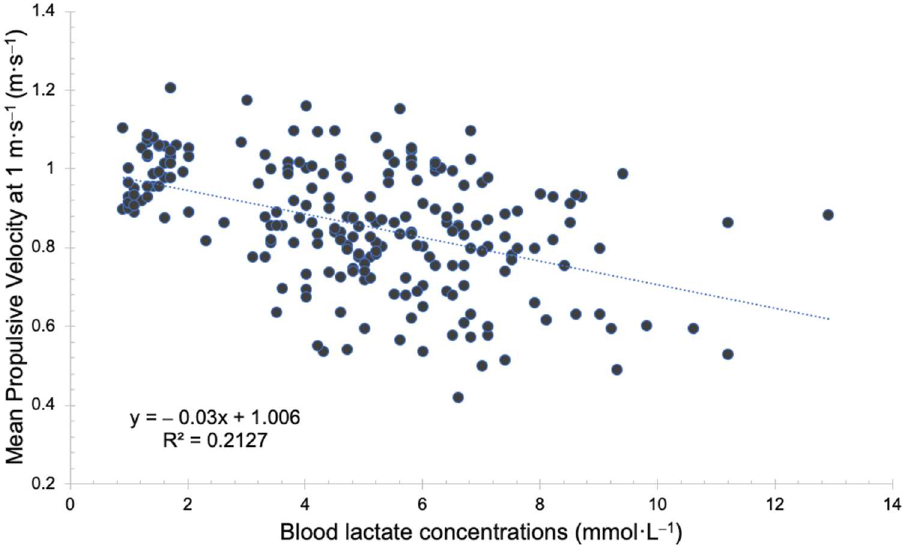
Figure 7. Linear regression between the blood lactate concentrations and MPV at 1 m · s − 1 before the exercise protocol and at minute 0, 5, 10 and 15 after the BP exercise protocol of the 44 participants.